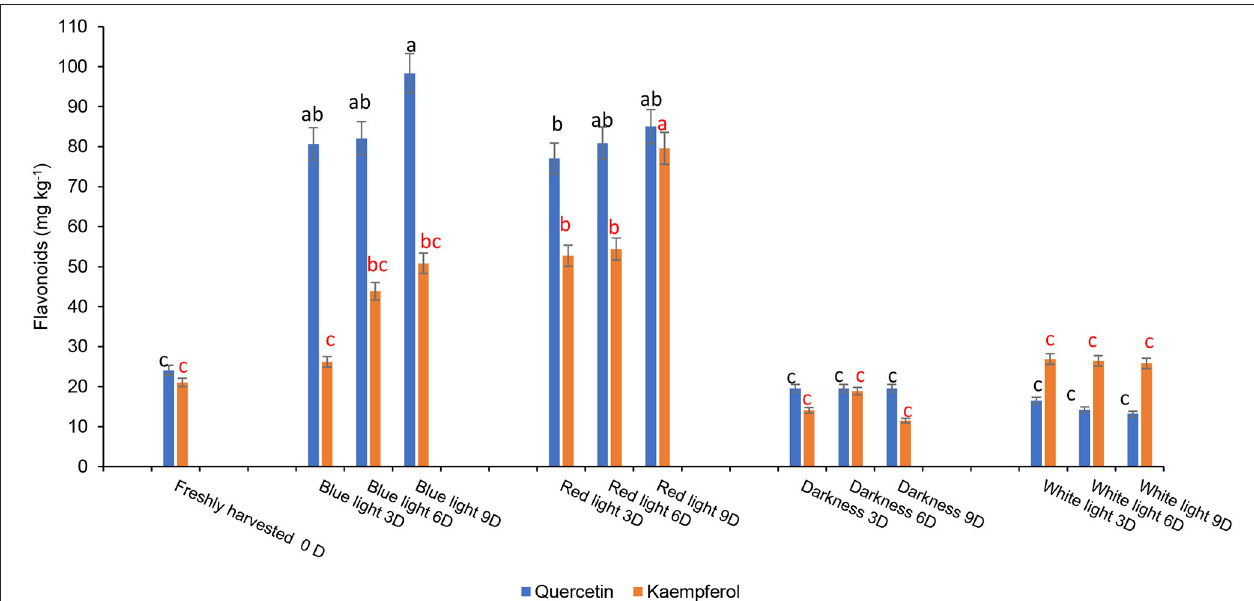
FIGURE 7 | Effect of blue and red LED light treatments on the changes in the concentration of major flavonoids in coriander ( Coriandrum sativum ) leaves. Different letters in the same bar indicate significant differences at p < 0.05.